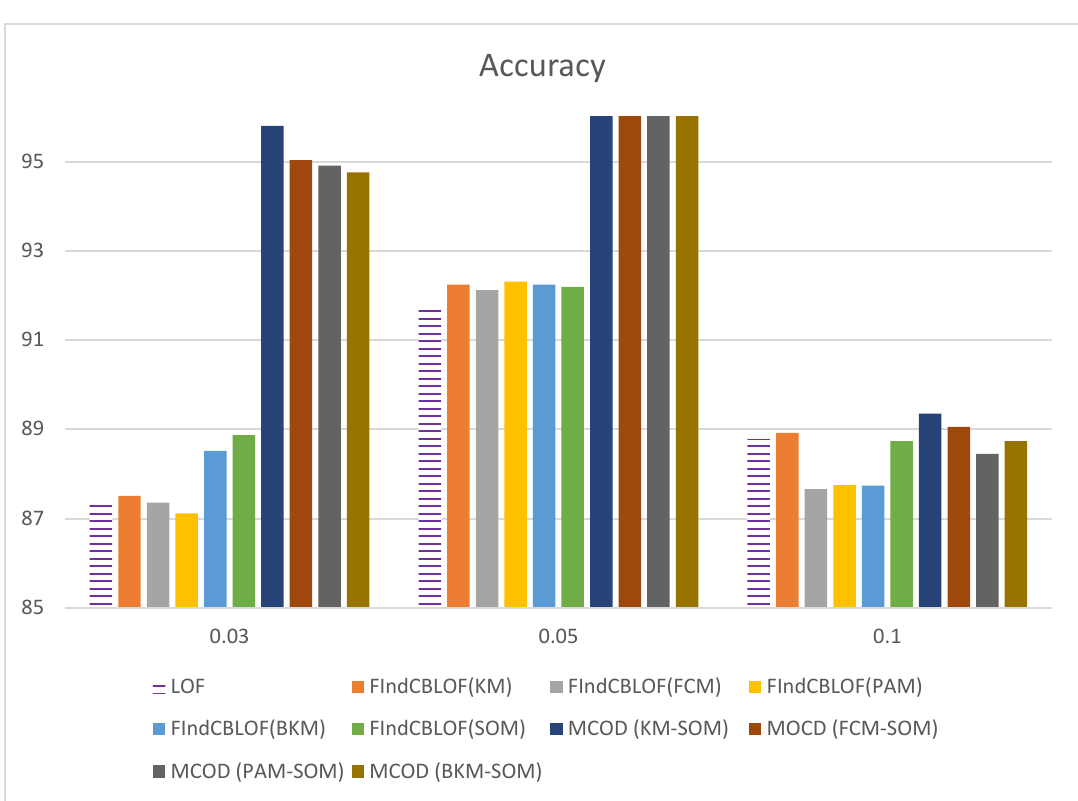
Figure 2. AUPRC (RBC Dataset).